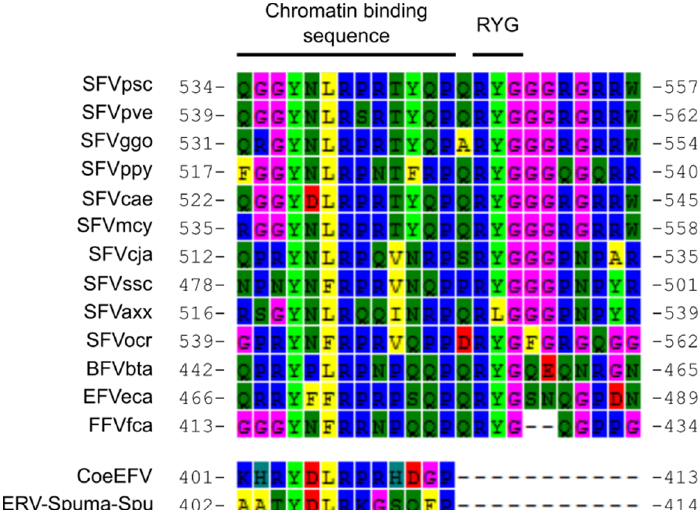
Figure 4. An alignment of chromatin-binding sequences (CBS) and surrounding regions. CBSs of CoeEFV and ERV-Spuma-Spu are intact. The conserved tyrosine (Y; 4 th column) and arginine (R; 7 th column) residues in the CBS, which are essential for Gag mitotic chromosome binding and nuclear accumulation of Gag and genomic DNA [49,54,55], could be found in all viruses. The arginine-tyrosine-glycine (RYG) residues, which are also important for nuclear accumulation of FV Gag and DNA [55], were absent from CoeEFV and ERV-Spuma-Spu but could be found in all mammalian FVs.